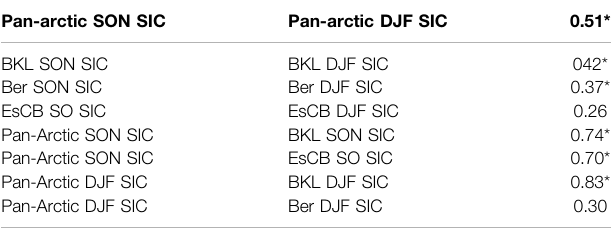
Asterisk indicates correlation statistically signi fi cant at the 95% con fi dence